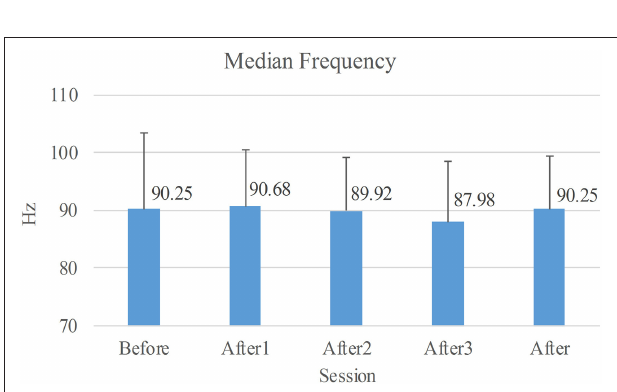
FIGURE 6 | Average of median frequencies of sEMG. Before: the long voluntary session before NMES sessions. After1/2/3: the short voluntary session after the 1st/2nd/3rd stimulated session. After: the voluntary session composed of the three short voluntary sessions after the stimulated sessions.